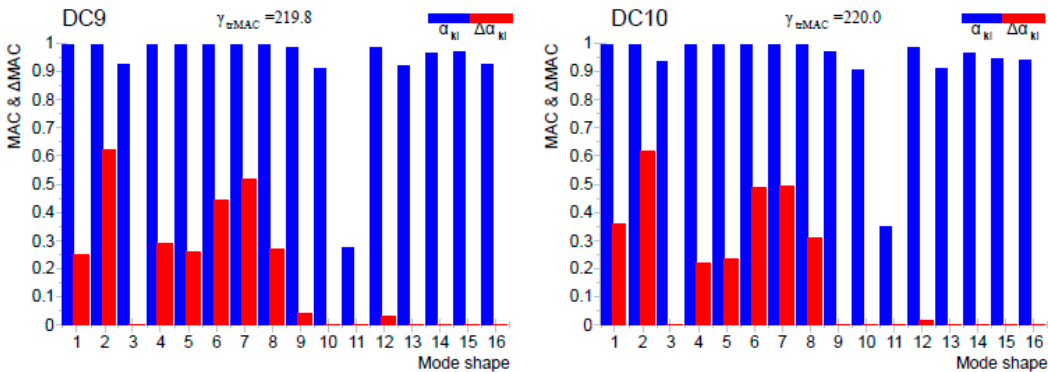
Figure 12. Diagonal elements of the MAC and Δ MAC matrices for damage cases DC5–DC10.